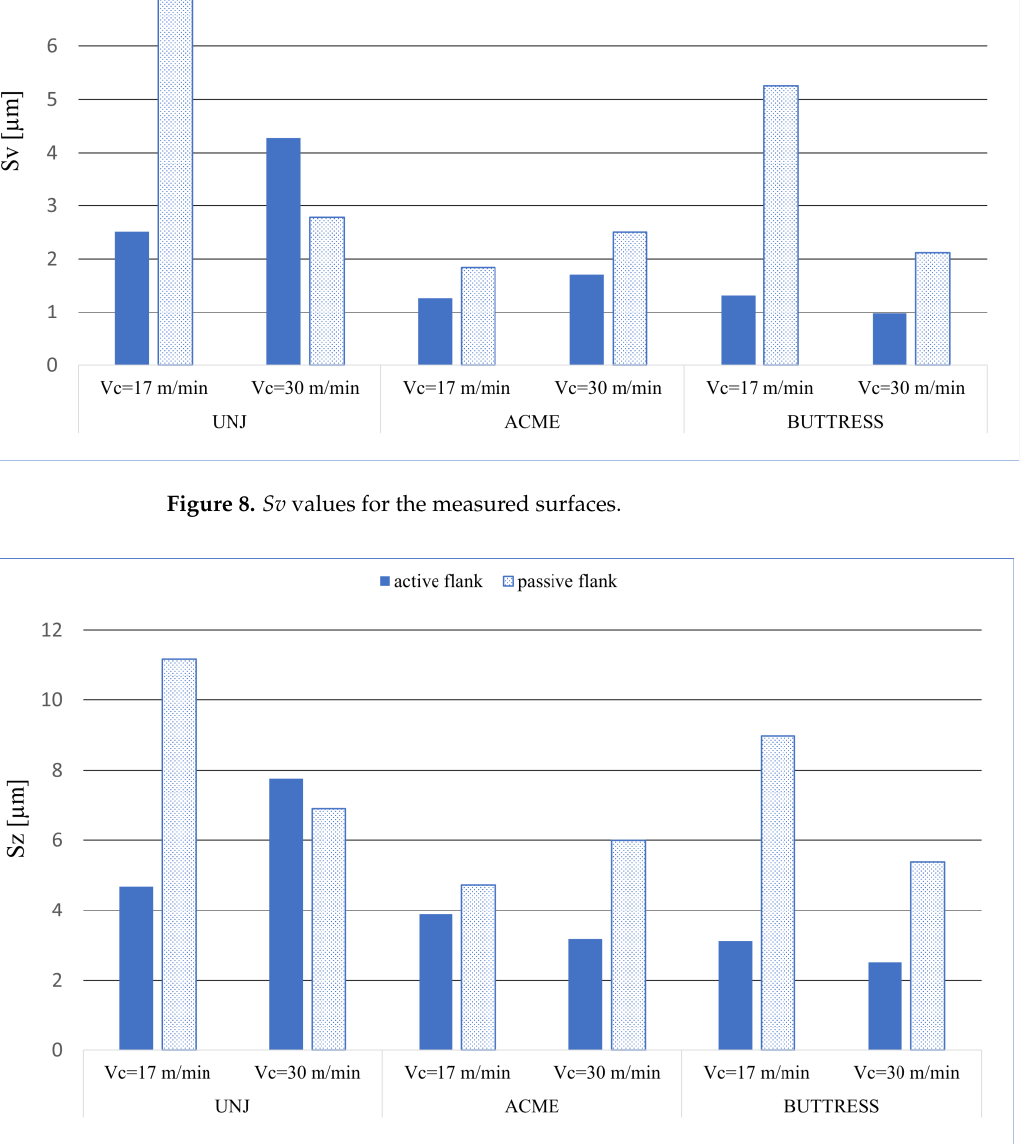
Figure 9. Sz values for the measured surfaces.